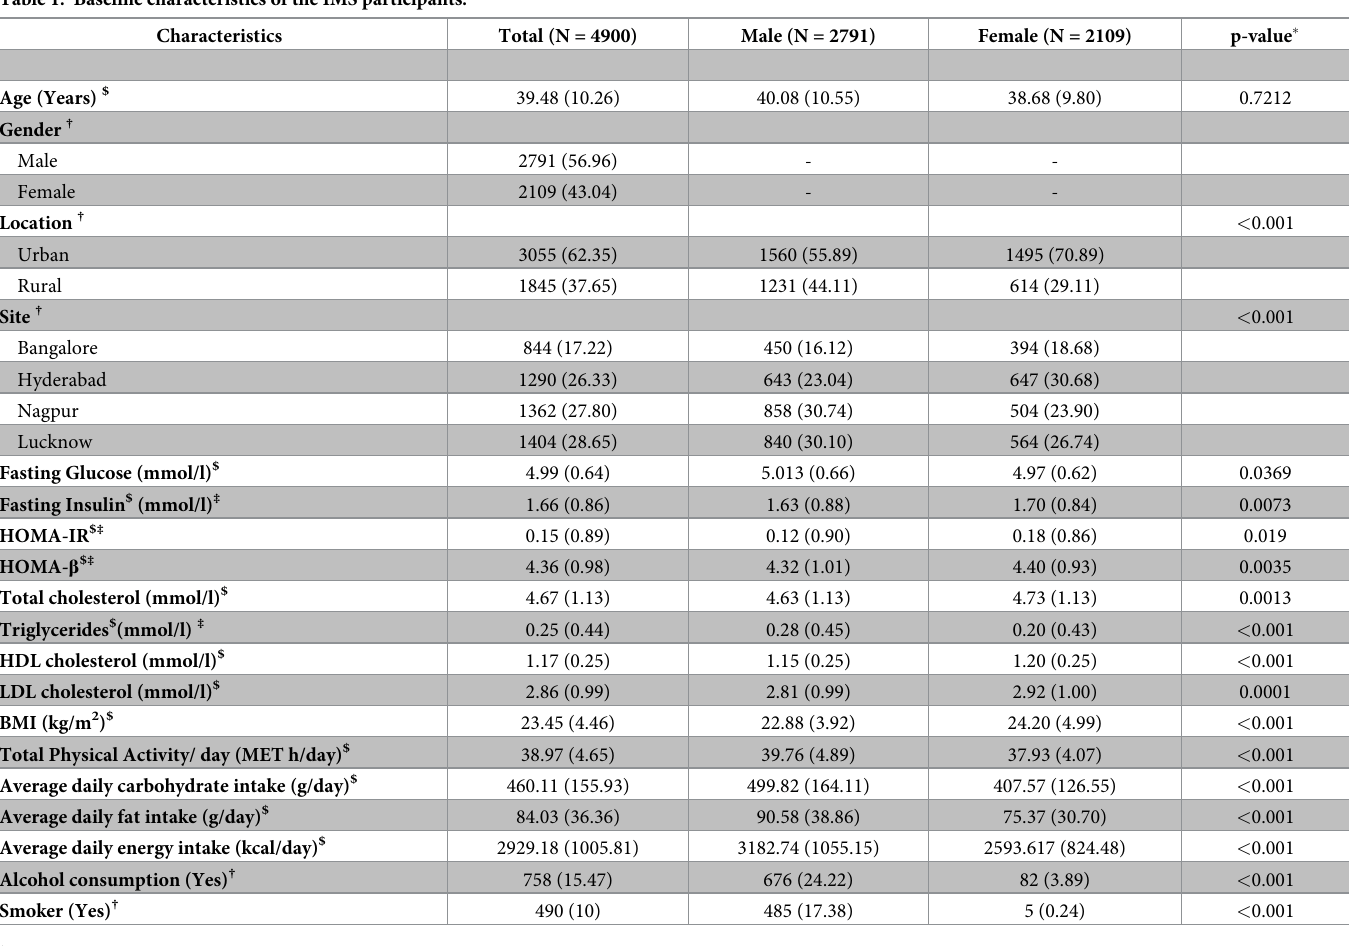
Table 1. Baseline characteristics of the IMS